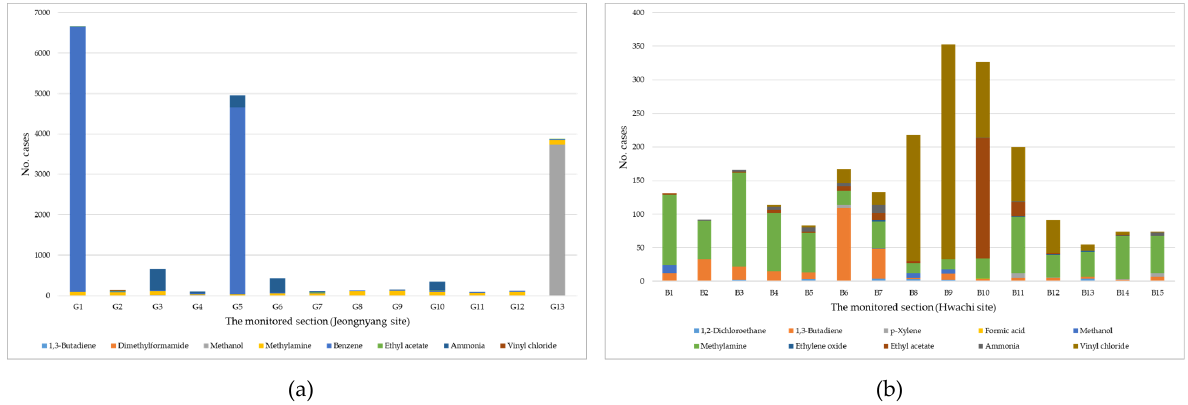
Figure 9. Result of each chemical substance detected in the monitored section at the ( a ) Jeongnyang site, and ( b ) Hwachi site.